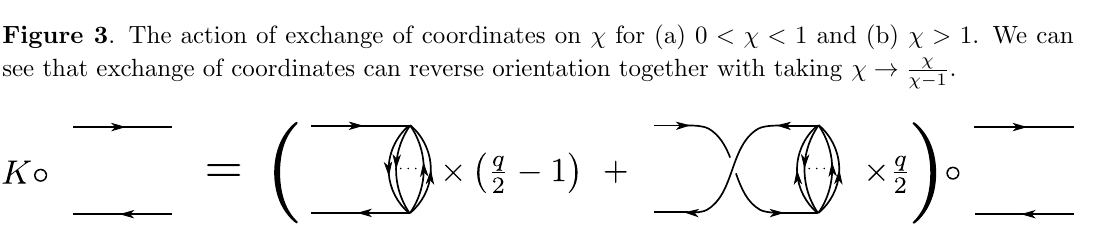
Figure 4 . The kernel for complex fermions. The (cid:12)rst term has q arrows pointing down in the rung; the second term has q pointing